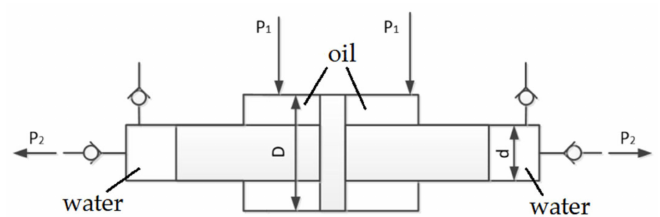
Figure 1. Schematic diagram of double-acting pressurized